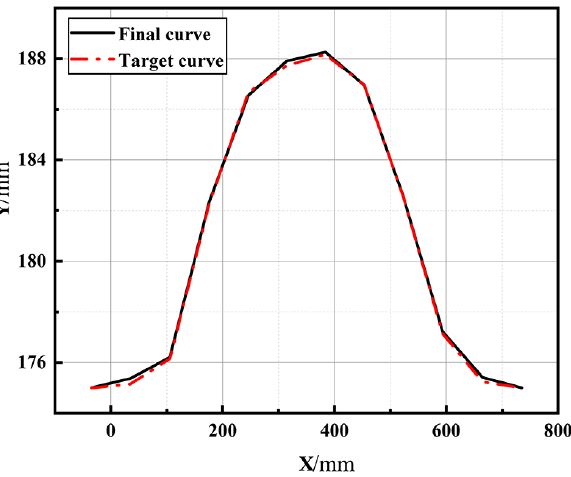
Figure 23. The finite element analysis result of the optimal cell arrangement.